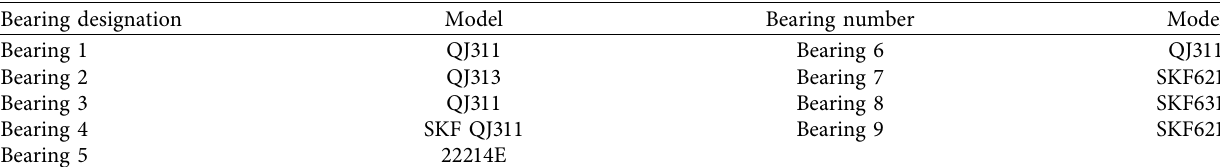
Figure 2: Transmission system schematic diagram. Table 1: Bearing model.